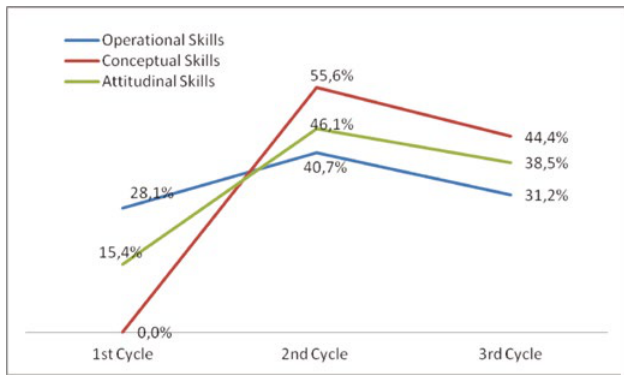
Figure 4: Skills by the level of education - Portugal.